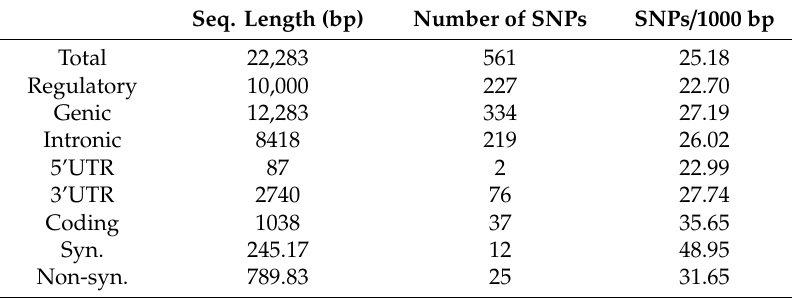
Figure 7. Sequence logos reveal signatures of functional divergence within each kingdom. Multiple sequence alignments were generated for BAG1 homologs from ( A ) animals, ( B ) plants, and ( C ) fungi. After editing (like we did for Figure 6) to remove gaps, sequence logos were generated for a particular region within the BAG domain (aa 160–183). Positions marked with a black asterisk represent highly conserved amino acids required for Hsp70 interaction [25]. Positions marked with a red asterisk represent conserved differences between kingdom-specific BAG1 homologs. Sequence logos were generated using sequences from 129 animals, 32 plants, and 5 fungi species. Table 1. SNPs present within BAG1